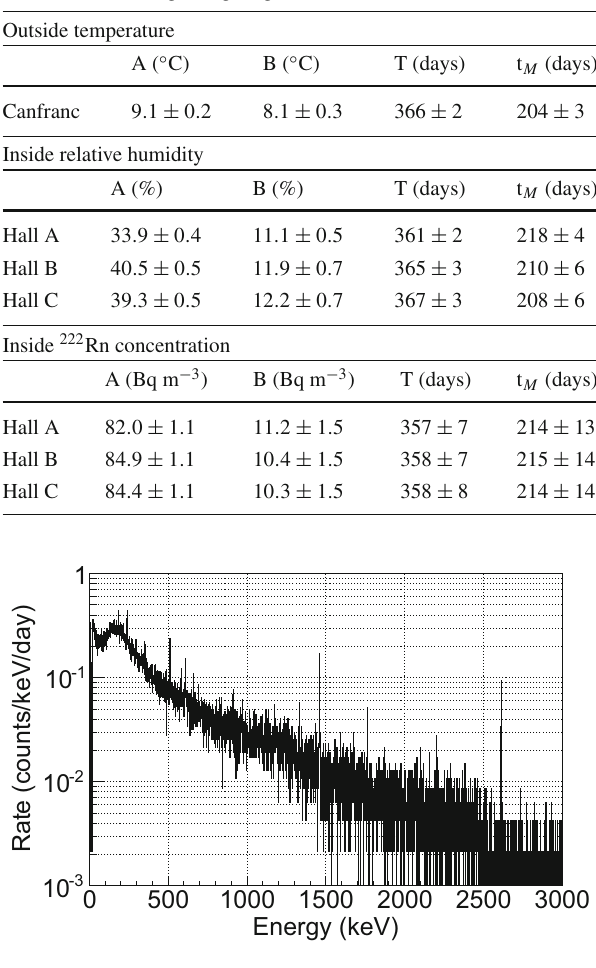
Table 7 Values of the fitted parameters (2015–18) according Eq. (2) of the variables showing seasonal periodicity: outside temperature (maxi- mum on 23 July), inside relative humidity and inside radon concentra- tion (maxima on beginning August)